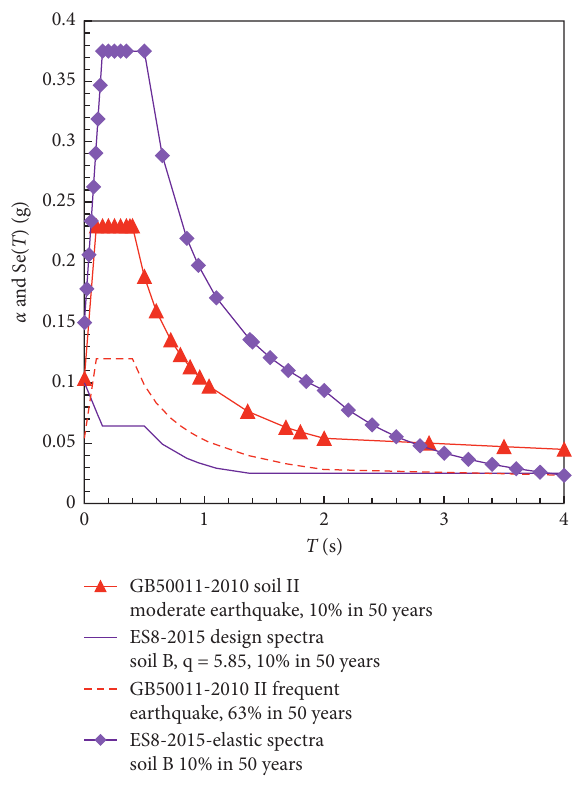
Figure 2: Design response spectrum of GB11-10 and